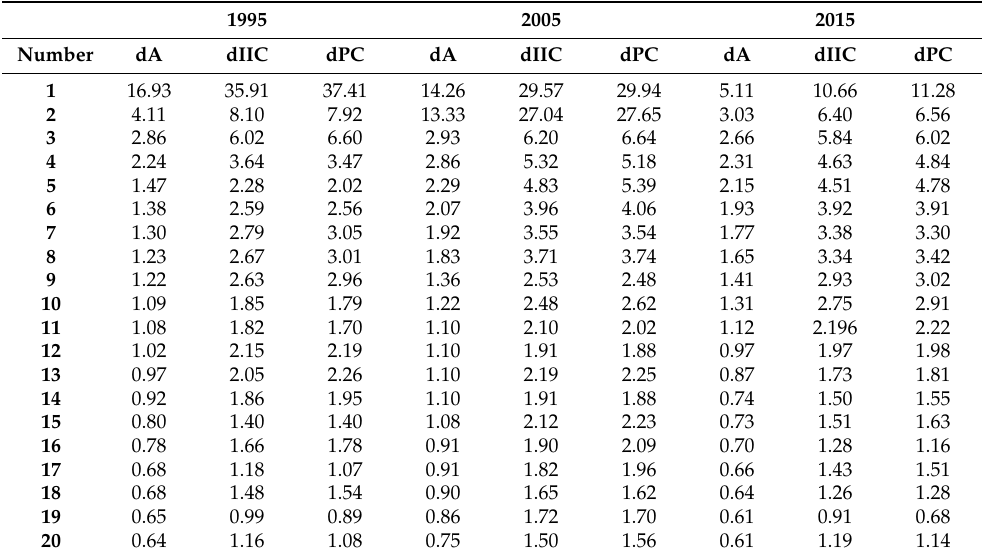
Table 3. Top 20 patch importance index ranking results from 1995 to 2015 in PRDR.